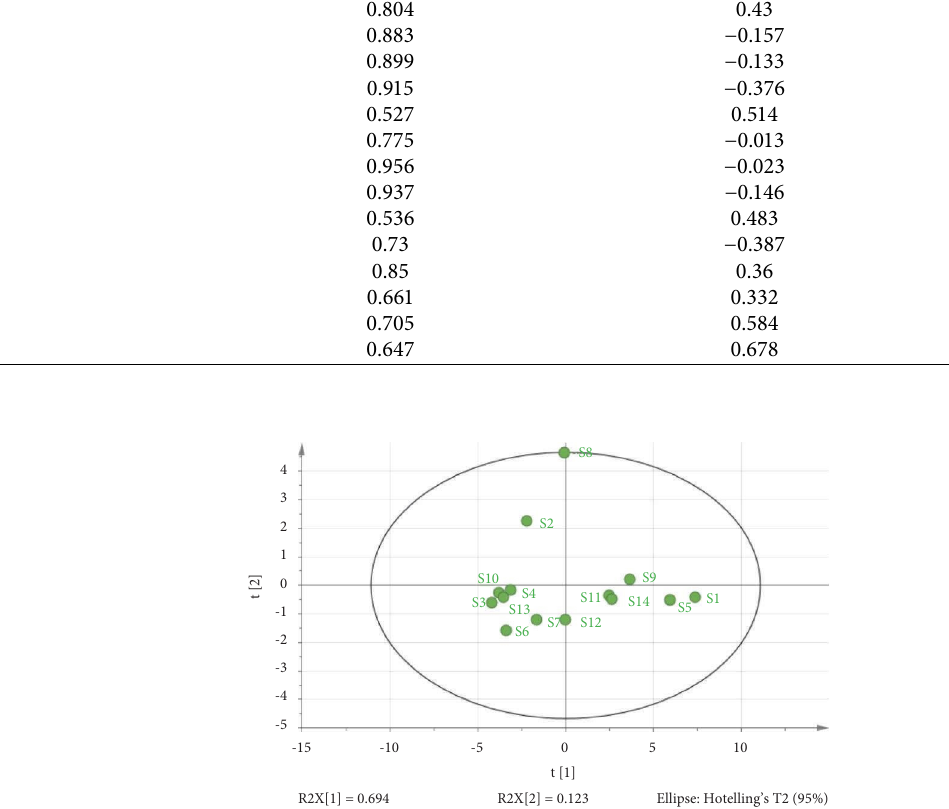
Figure 7: PCA scores plot for the twenty-one common chromatographic peaks obtained from each of fourteen samples. Table 11: Te results of grey relational coefcient of 14